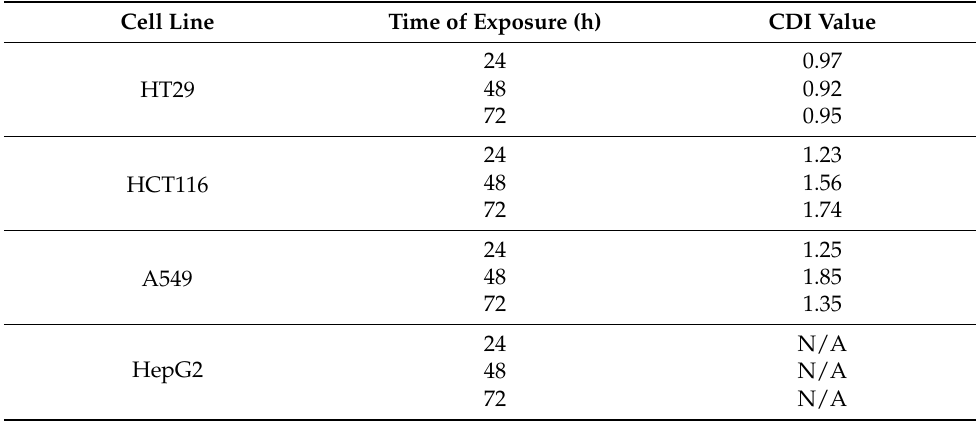
Table 1. CDI values for the two agents, PBT and 5FU, when used as mixture.